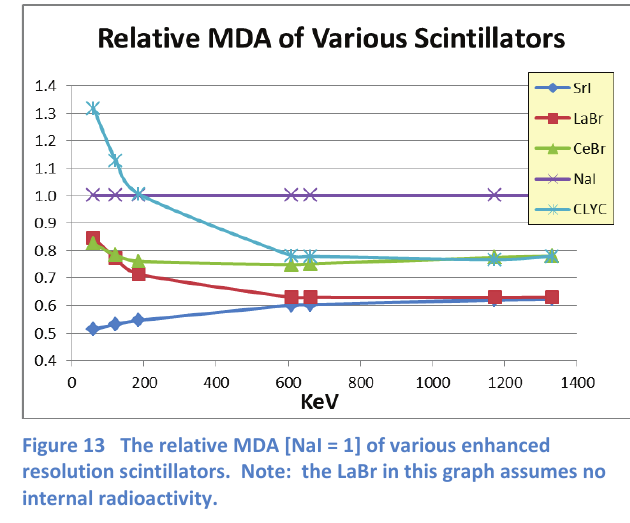
Figure 13 The relative MDA [NaI = 1] of various enhanced resolution scintillators. Note: the LaBr in this graph assumes no internal